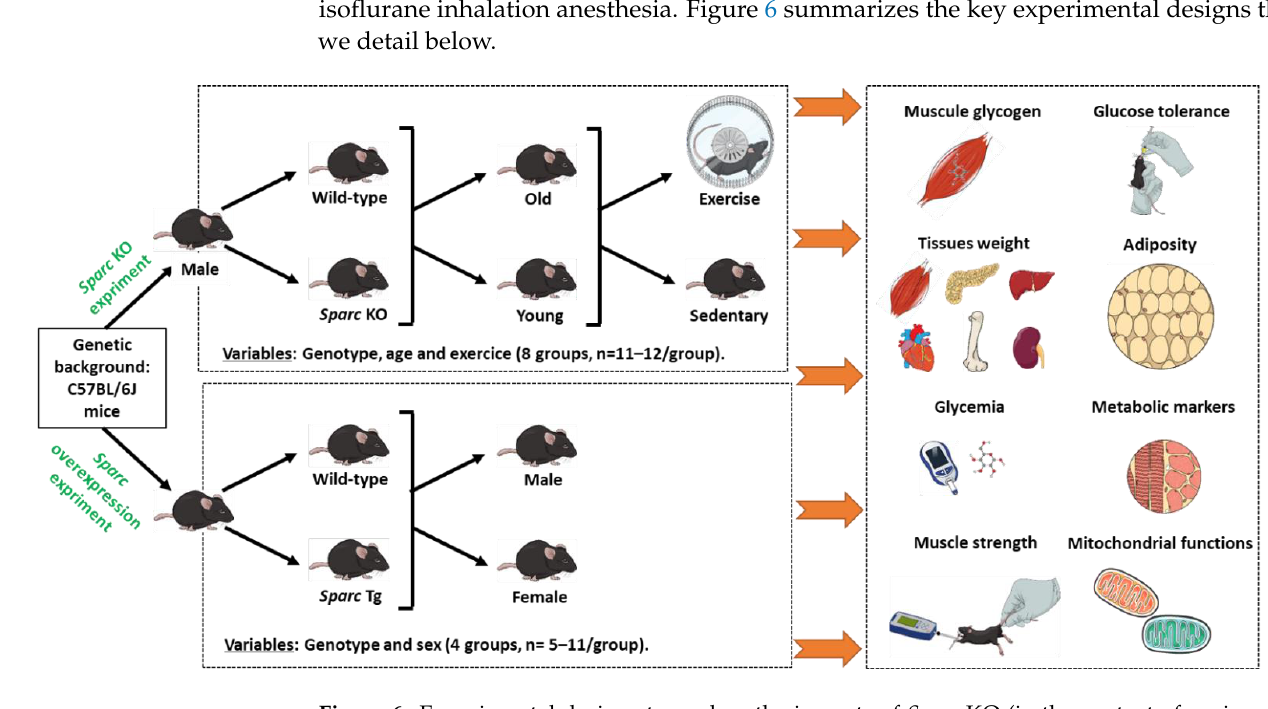
Figure 6. Experimental designs to explore the impacts of Sparc KO (in the context of ageing and exercise) as well as the impacts of Sparc overexpression in both male and female mice. For each experiment, a number of parameters have been conducted. Abbreviations: KO, knockout; Sparc , secreted protein acidic and rich in cysteine; Tg, transgenic ( Sparc